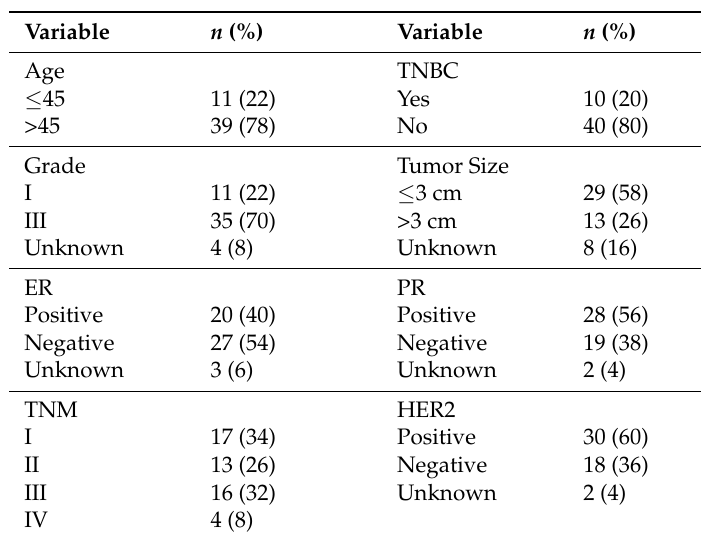
Table 1. Characteristics of the breast cancer patients in this